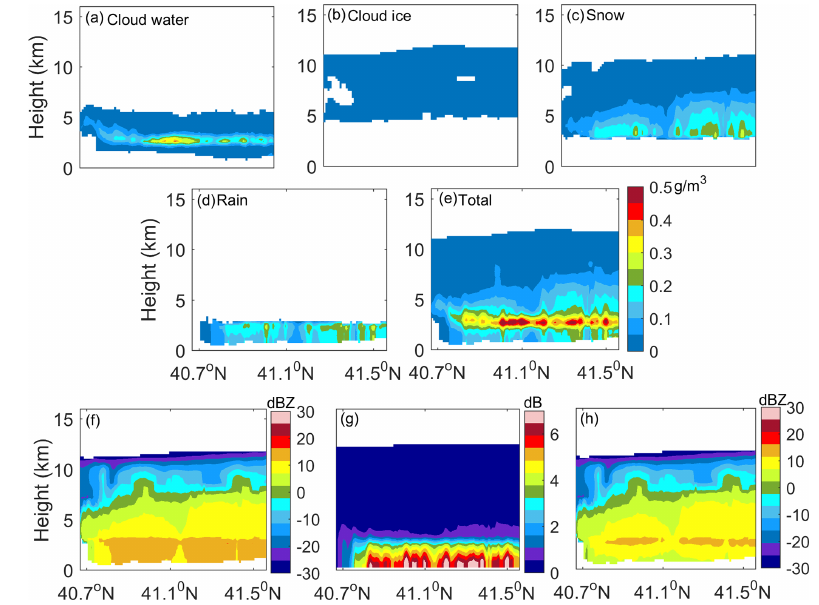
Figure 9. Latitude–height cross section of the hydrometeor for the stratiform case simulated by the WRF for (a) cloud water, (b) cloud ice, (c) snow, (d) rain, and (e) total hydrometeors. (f) Simulated unattenuated radar reflectivity with the total hydrometeors, (g) two-way attenuation, and (h) attenuated radar reflectivity. Owing to the Mie scattering effect, the unattenuated radar reflectivity did not decrease markedly at the bottom of the melting layer, whereas the bright band at the melting layer was highlighted due to strong attenuation in the rain